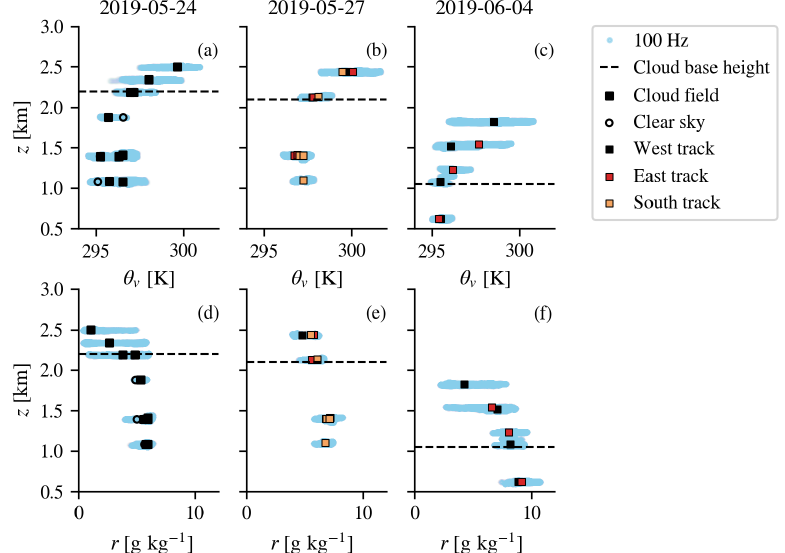
Figure 6. Virtual temperature and mixing ratio during the 3 flight days. On the first flight there were three legs that were partly below clear sky and partly below cloudy sky. They have been separated and are represented by open circles and closed squares, respectively. The other two cases had multiple tracks that are indicated with different colours. The raw 100Hz data are indicated in light blue. Cloud base is indicated by the horizontal dashed line.